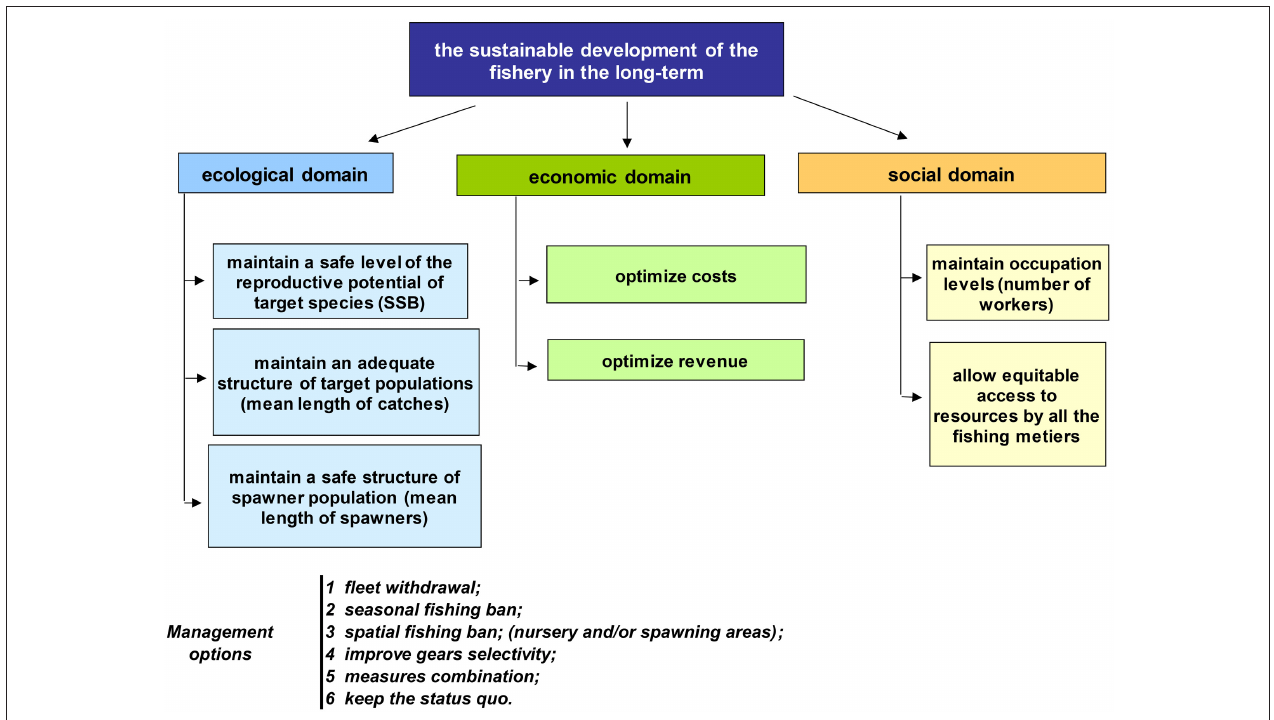
FIGURE 2 | Decision Tree of survey 2. The NSFDSS decision tree, indicating the goal, the three main components (ecological, economic and social), the objectives, and the management options.